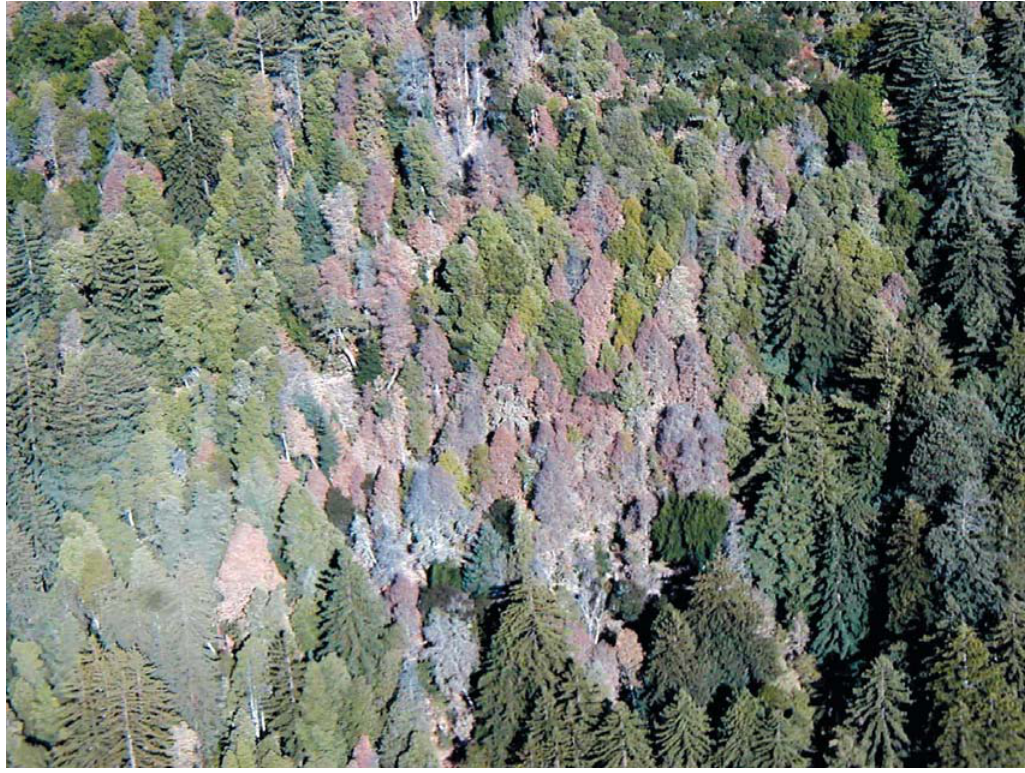
Fig. 1. Overstory mortality of tanoak ( Lithocarpus densiflorus ) caused by Phytophthora ramorum in Monterey Co. (Big Sur), CA, USA. (Photo by S.